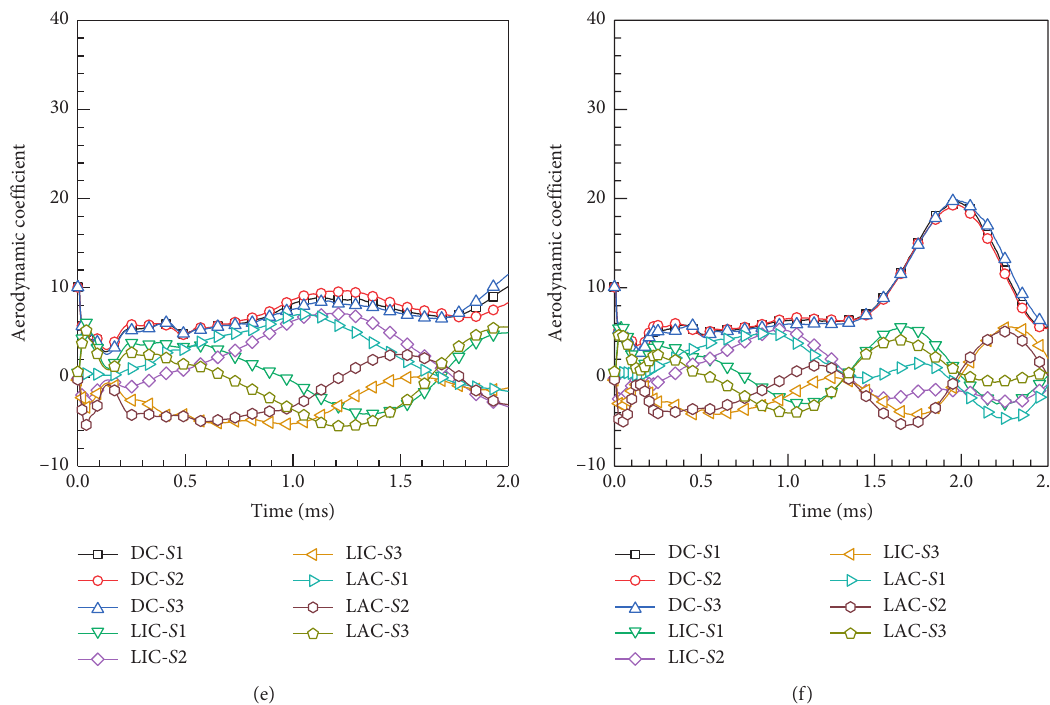
Figure 9: Aerodynamic force coefficients. Letters a–f stand for cases 1–6, respectively. DC is the drag coefficient, LIC is the lift coefficient, and LAC is the lateral force coefficient.